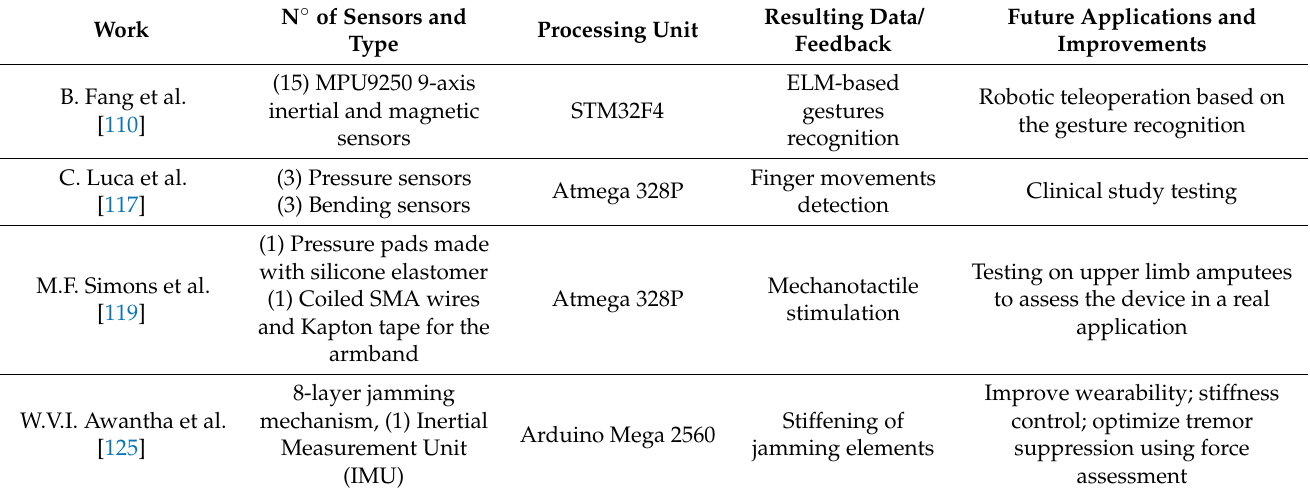
Table 4. Summarizing table with the smart gloves previously analyzed and compared in terms of sensors’ typologies and number, processing unit, and future applications and